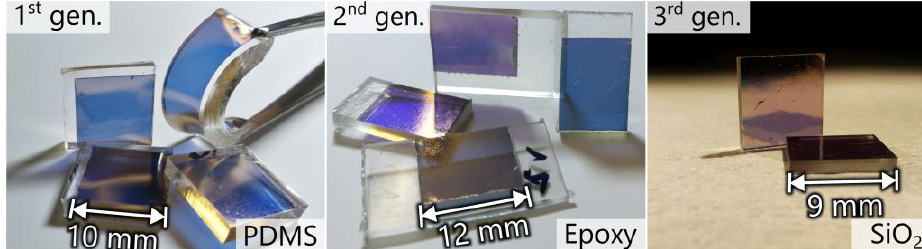
Figure 2. Photographs of three generations of AuNP nanocomposites.